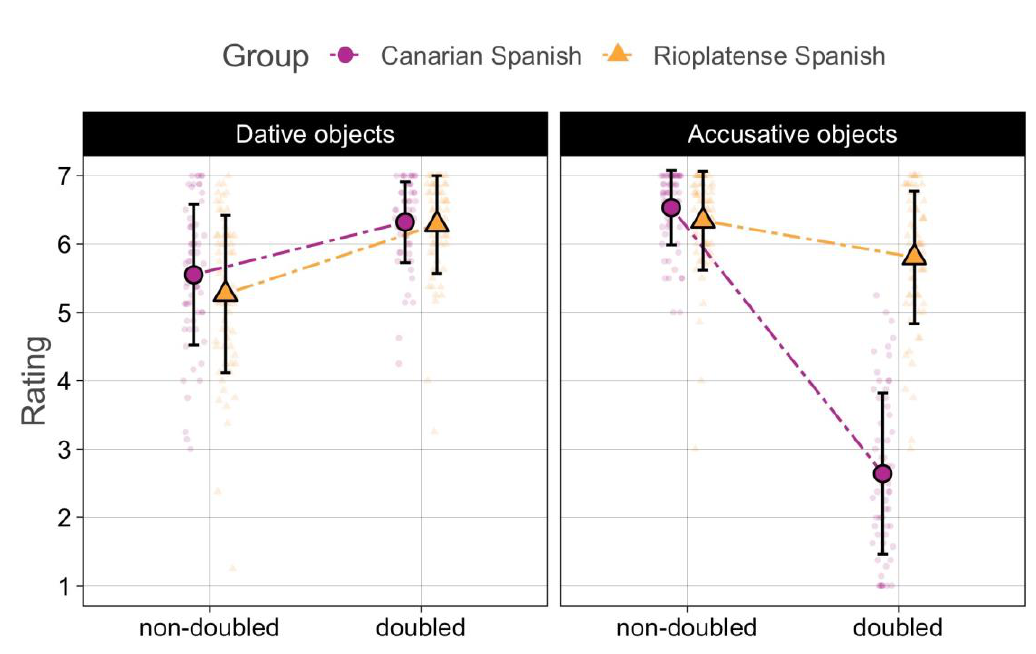
Figure 1. Acceptability ratings of sentences with dative and accusative objects compared between speaker groups. Circles reflect by-condition averages across participants, and error bars show +/- 1 standard deviations. Each point represents an individual participant. Canarian and Rioplatense Spanish speakers reacted similarly to the doubling of dative objects. By contrast, the two groups differed in their responses to doubled accusative